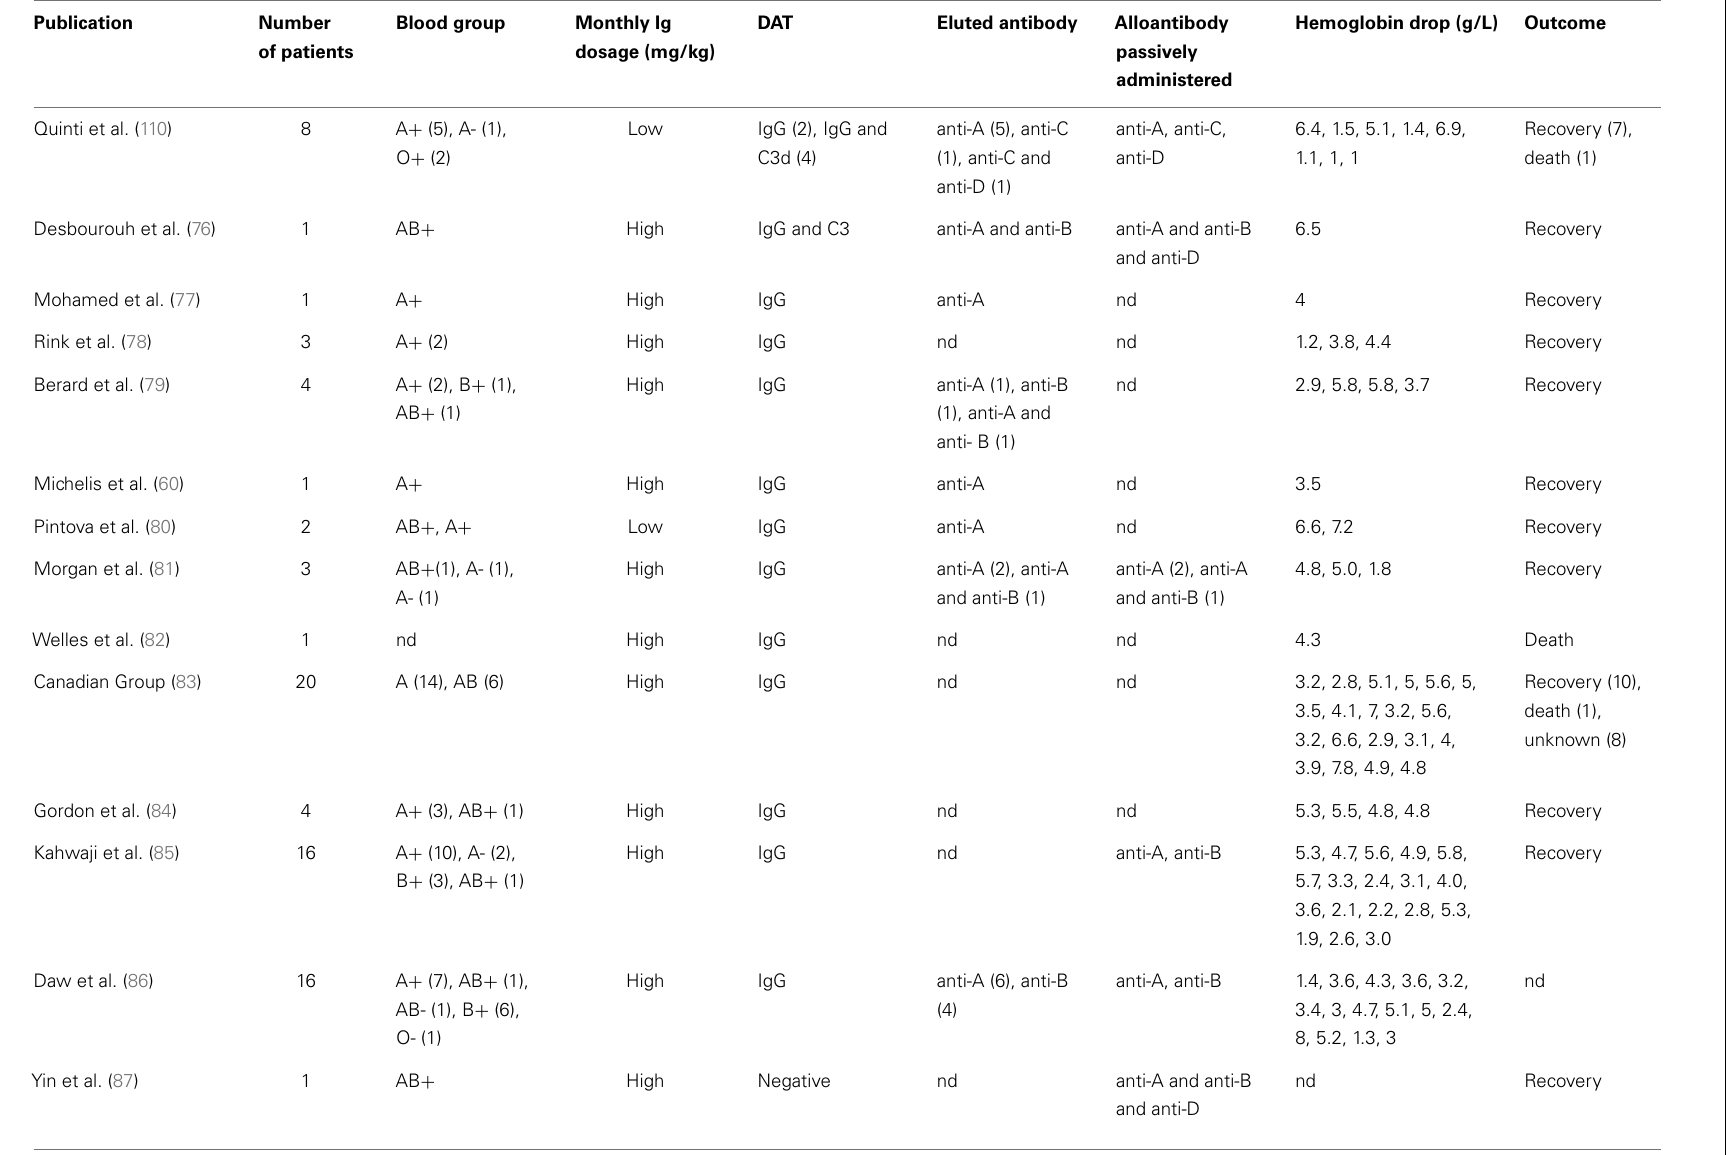
Table 2 |The missing oxygen on the dark side – Ig-induced hemolysis in recipients of polyvalent immunoglobulins